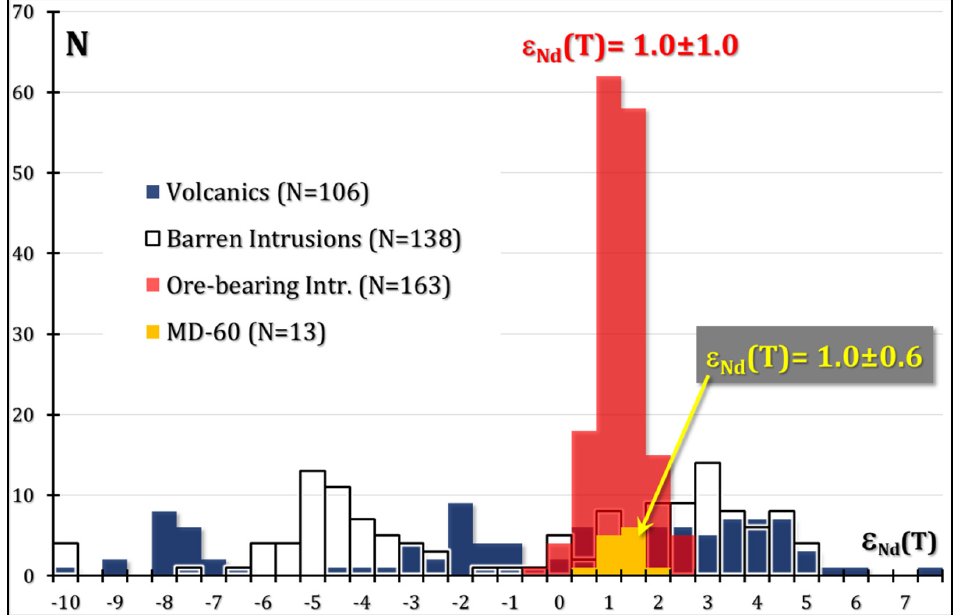
Figure 9. Summarized histograms of the Ԑ Nd (T) values in magmatic rocks of the Norilsk region. Data sources are shown at the Figure 8.